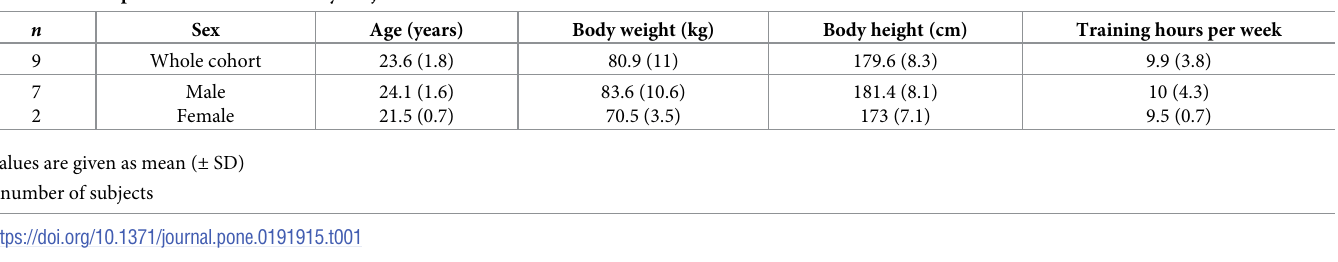
Table 1. Anthropometric data of the study